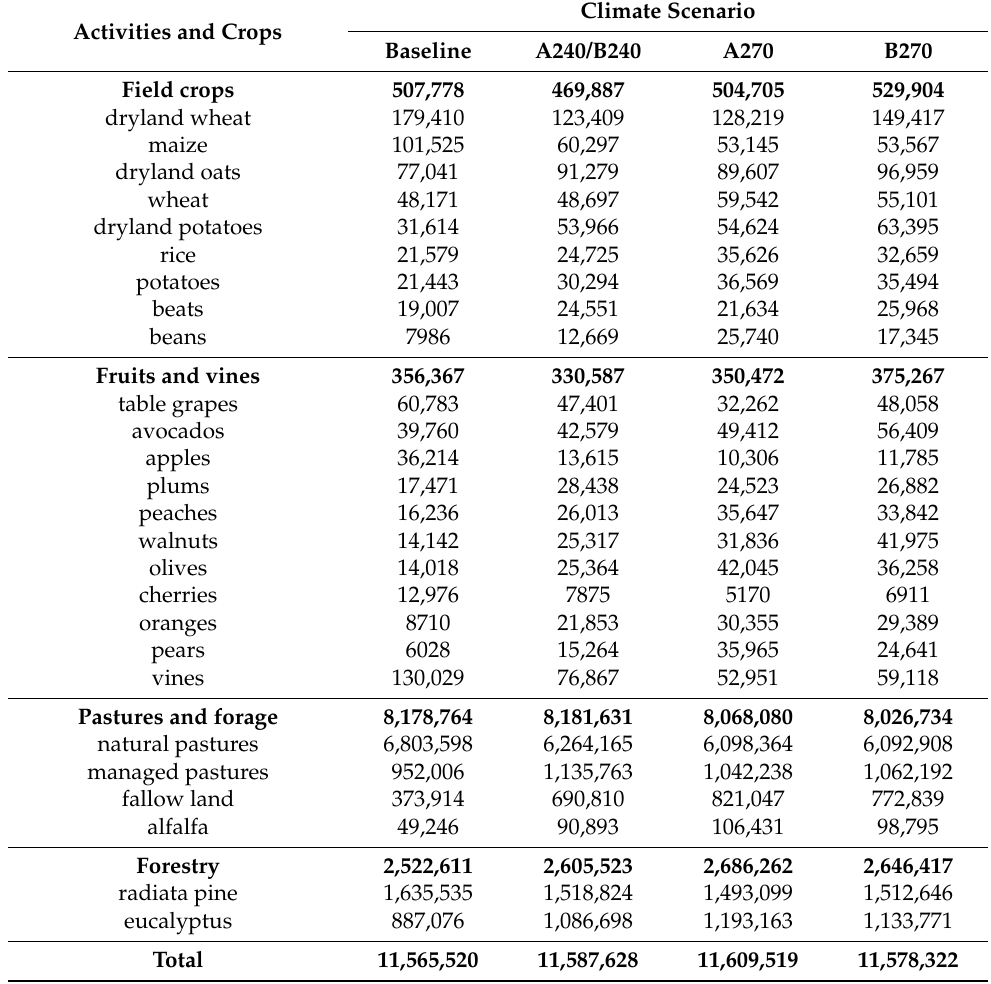
Table 1. Land use by activity and crop under different climate-change scenarios